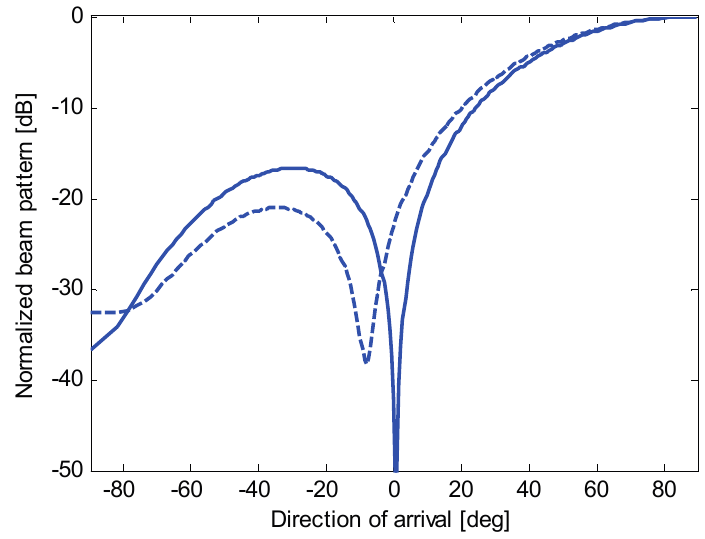
Figure 14. Nominal beam pattern (solid line) and actual beam pattern (dashed line) for oversteered beamforming with optimum real weights applied to an end-fire array of eight